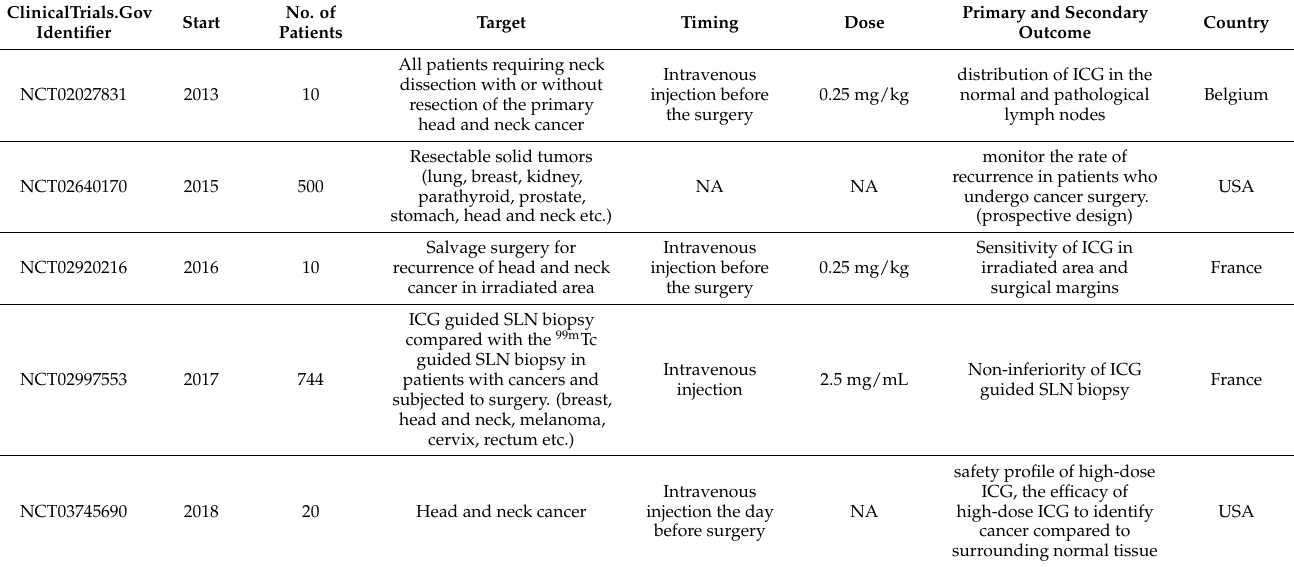
Table 3. Clinical trials of ICG guided tumor and sentinel lymph node imaging in head and neck cancer. ClinicalTrials.Gov